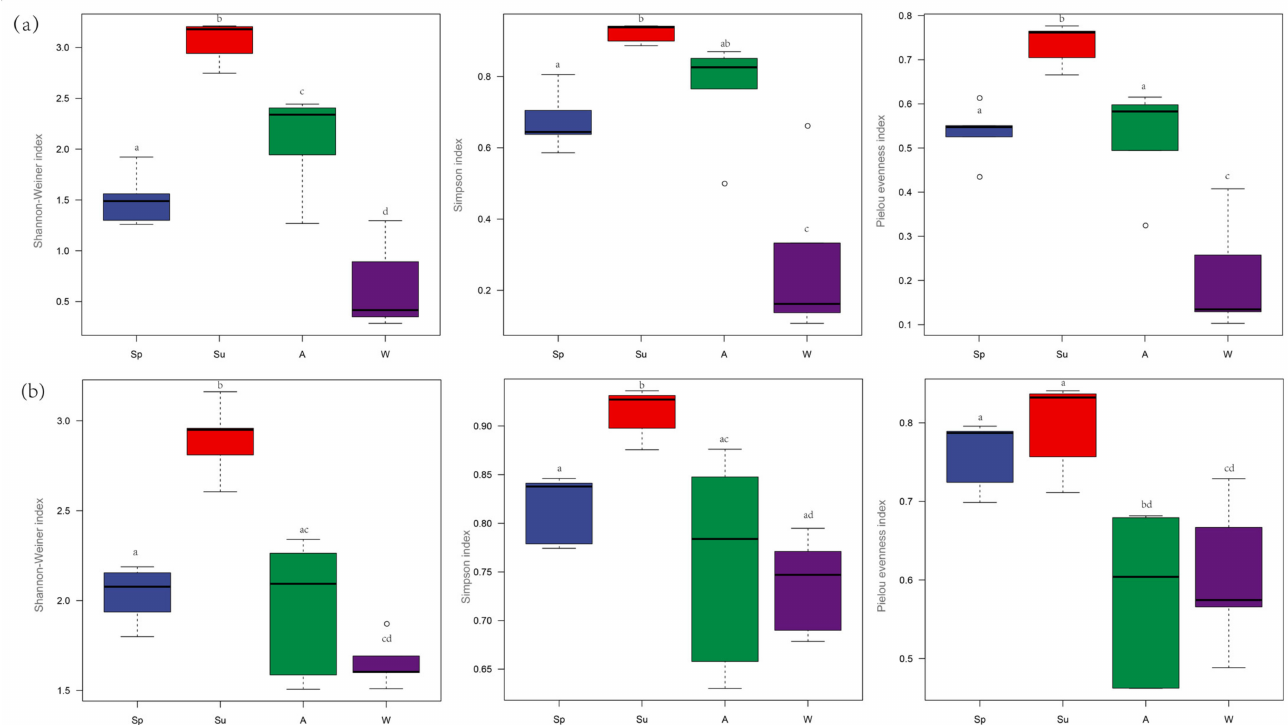
Figure 6. Seasonal variation of zooplankton α − diversity. ( a ) MBC; ( b ) MOI, including the Shannon– Weiner Index, Simpson’s Index, and Pielou Evenness Index. SP: spring; SU: summer; A: autumn; W: winter. a, b, c, d are marked letter, the difference is insignificant if there is a same marked letter, otherwise significant if there is a different marked letter. o is the